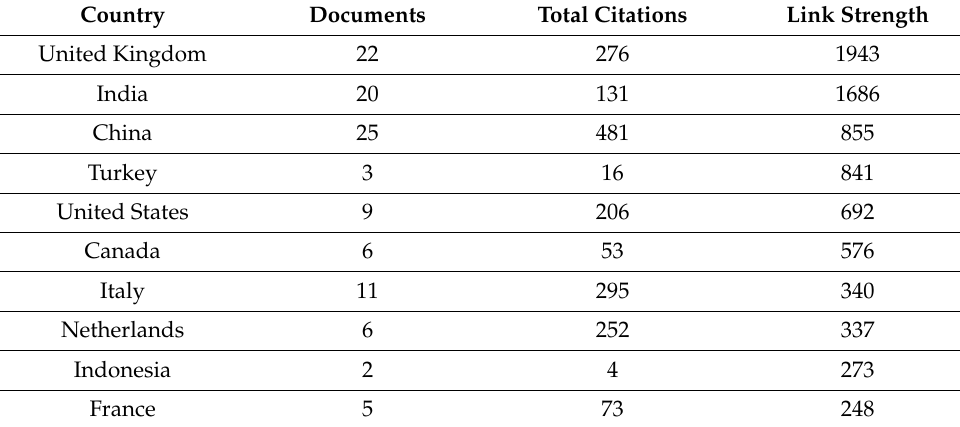
Table 5. Research Link Strength and Citations between Countries